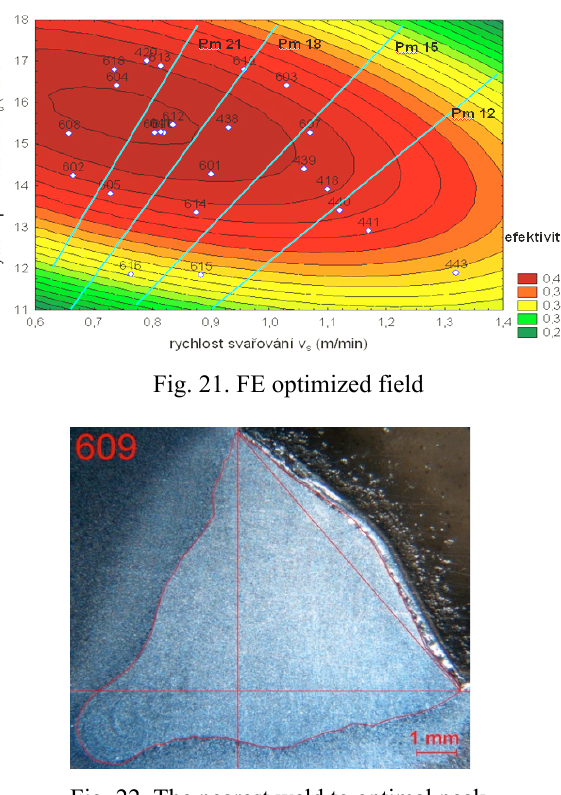
Fig. 22. The nearest weld to optimal